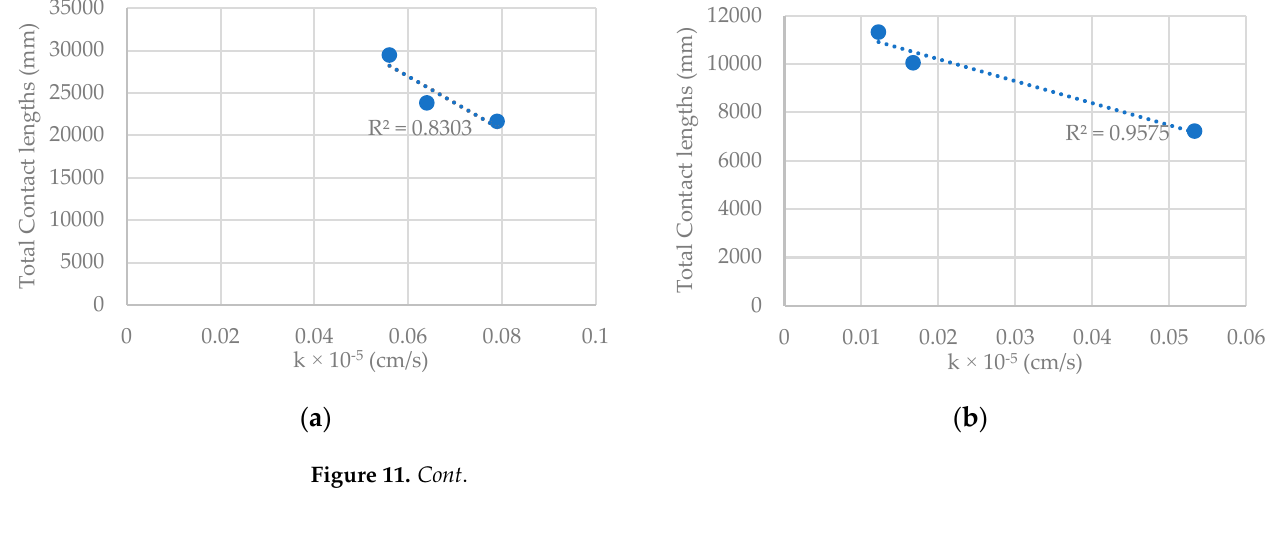
Figure 10. Correlation of number of contacts calculated for the skeleton with permeability, ( a ) AC60/70 with dense gradation, ( b ) AC60/70+CB with dense gradation, ( c ) AC60/70+SBS with porous gradation, and ( d ) the combination of dense gradation set ( a , b ).